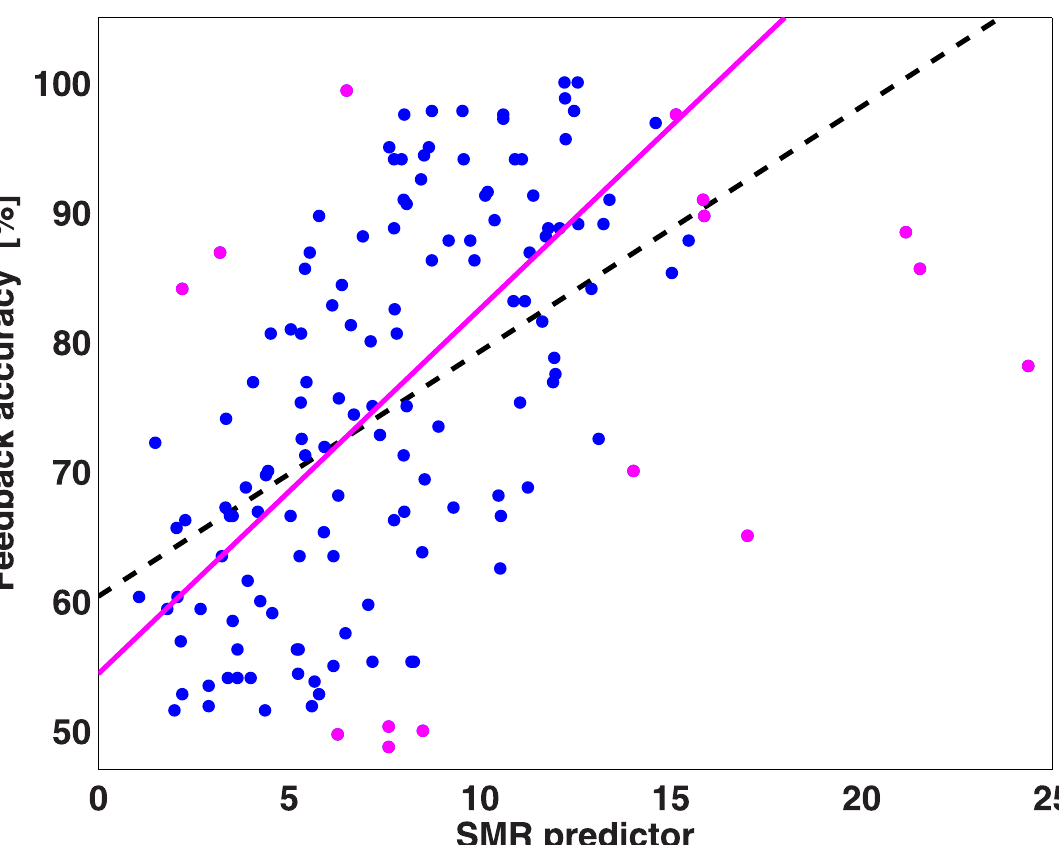
Fig 6. Predictor of BCI performance. The predictor is calculated from 2.5 minutes of recording of the brain in resting state with eyes open and correlated with the mean feedback accuracy for each participant (blue dots). The back dashed line pictures the linear regression between the predictors and the accuracies (r = 0.53). The magenta dots are the values detected as outliers. After the exclusion of the outliers, a higher correlation of 0.66 is reached (magenta